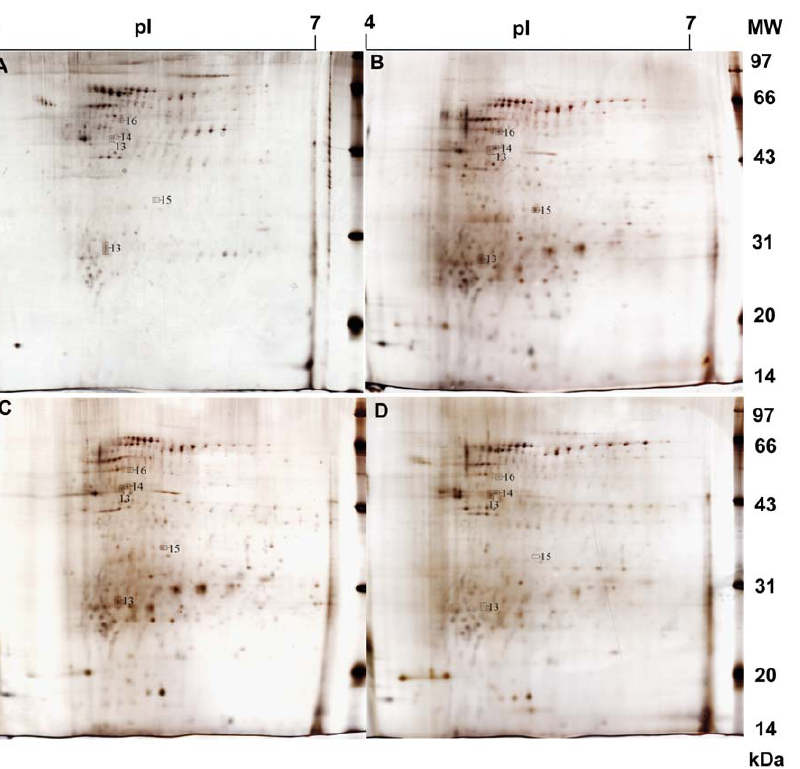
Figure 3. The 2-DE images of the membrane proteins from T.maritima cultured at the four temperatures. A), B), C), and D) exhibit the 2- DE images for the bacteria cultured at 60, 70, 80 and 90 u C, respectively.